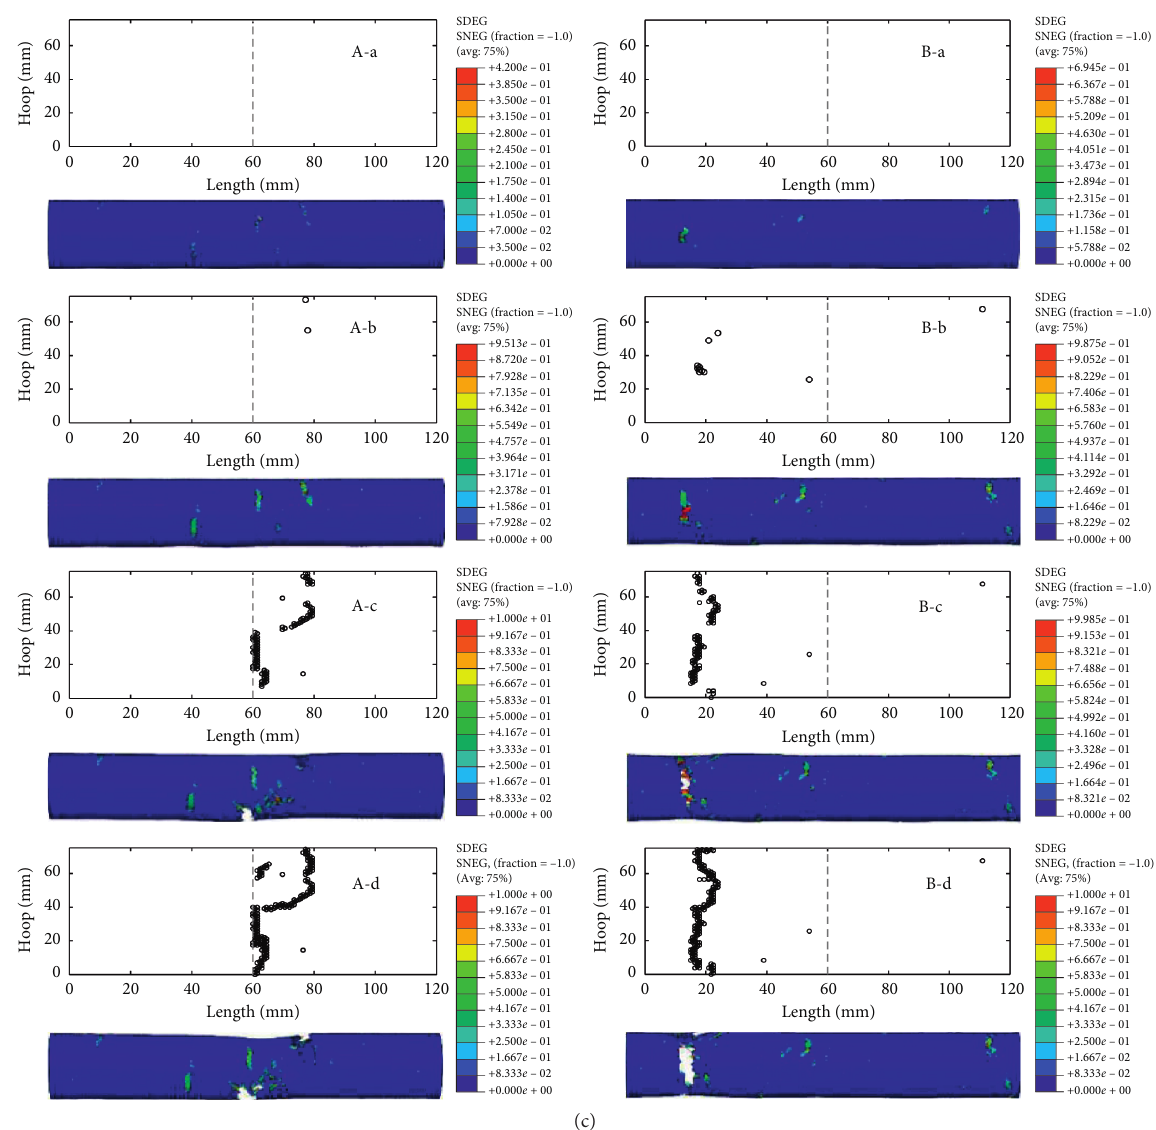
Figure 11: Damage evolution and fracture mode of corroded pipes with the same corrosion rate and variance. (a) Random field with a value of η � 45%and var � 0 . 10 mm , (b) simulated stress-strain curve, and (c) crack propagation at the points marked in